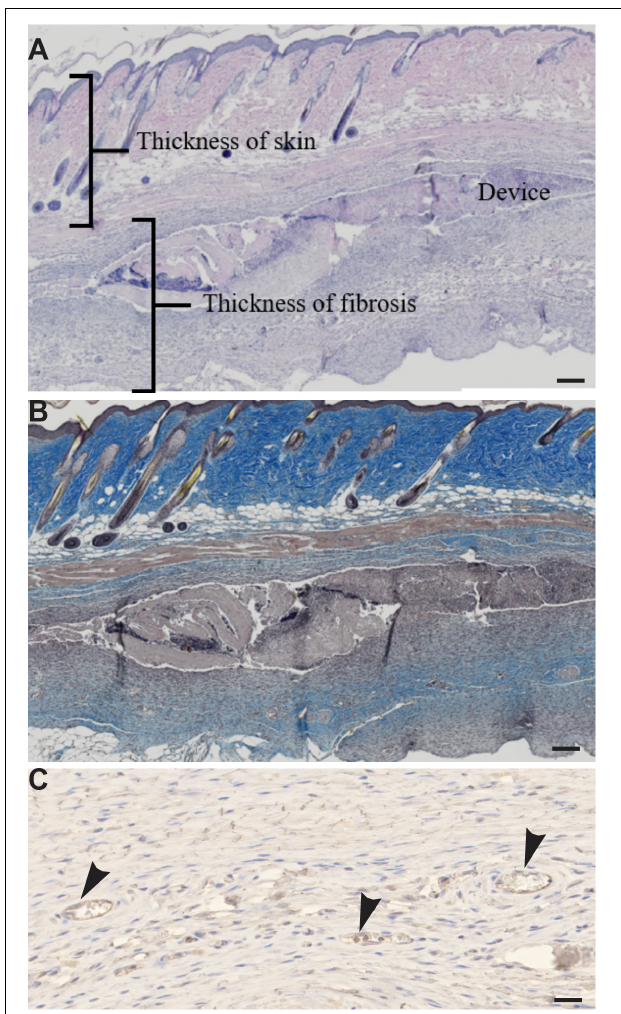
FIGURE 6 | (A,B) Tools to assess the biocompatibility of the device. (A) Hematoxylin-eosin staining on skin sections. (B) Masson’s trichrome staining on skin sections. (C) Immunohistochemistry of anti-von Willebrand factor antibody in skin sections shows endothelial cells (arrowhead). Scale bar = 200 µ